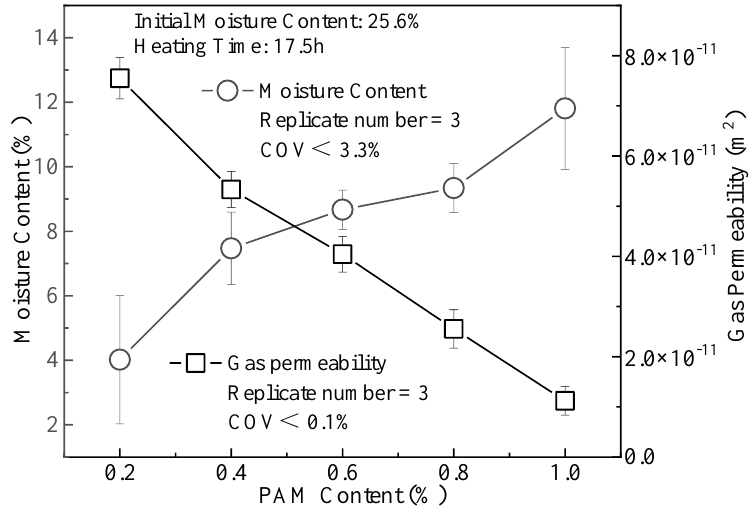
Figure 7. Influence of ZP content on gas permeability of the compacted clay.